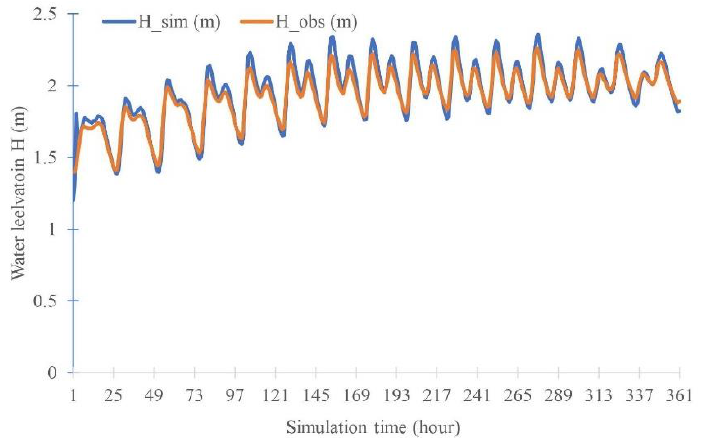
Figure 2. Simulated and observed water elevation H over 15 days for the friction of 0.016 (m). Notes: H_obs is the observed and H_sim is the simulated water elevation.